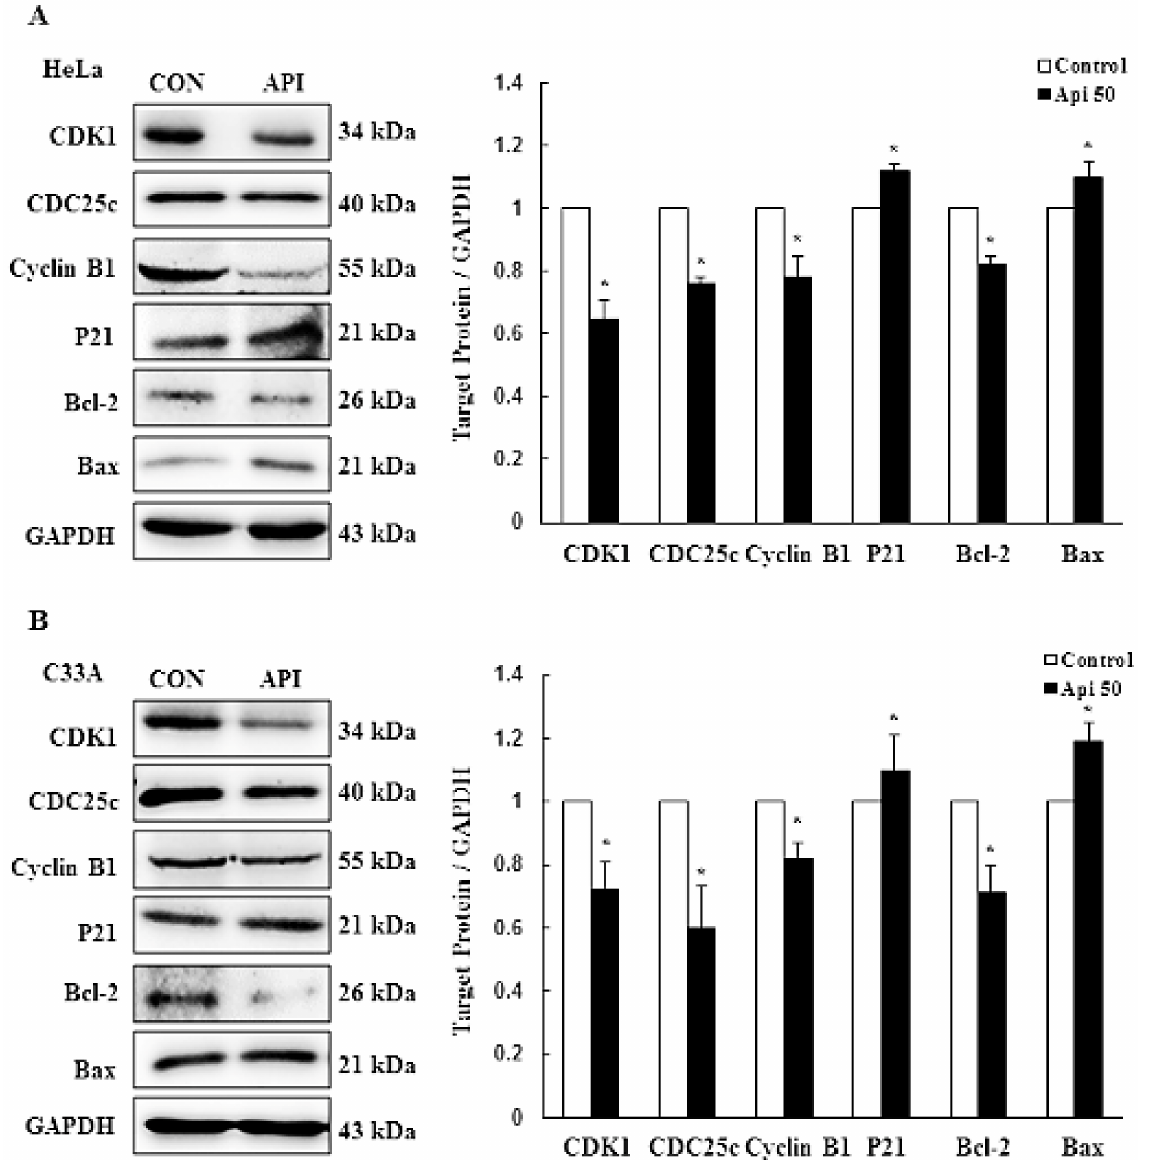
Figure 2. Proposed mechanism and signaling pathways of the apoptosis and cell cycle arrest induced by apigenin in cervical cancer cells. Cell cycle G2/M phase-related proteins CDK1, CDC25C, cyclin B1, and p21, and apoptosis-related proteins, Bcl-2 and Bax, were detected in HeLa ( A ) and C33A ( B ) cells with or without 50 µ M apigenin treatment for 24 h via Western blotting and quantified. Data are presented as the mean ± SD of at least three independent experiments. * p < 0.05 indicates a significant difference as compared with the corresponding control. CON, 0.1% DMSO; Api 50, 50 µ M